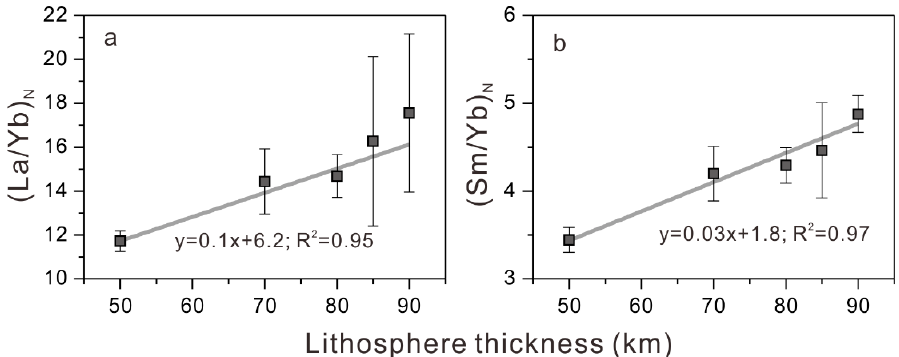
Figure 9. Variations of ( a ) (La/Yb) N and ( b ) (Sm/Yb) N ratios with lithospheric thickness beneath Pohnpei Island and Louisville seamounts. The ratios were averaged at 5 km intervals of lithospheric thickness for basalts with MgO contents of >6 wt.% for Louisville seamounts and >9 wt.% for Pohnpei Island. Error bars represent ±1SD. Louisville seamount data are from Beier et al. [56] and Vanderkluysen et al. [51].